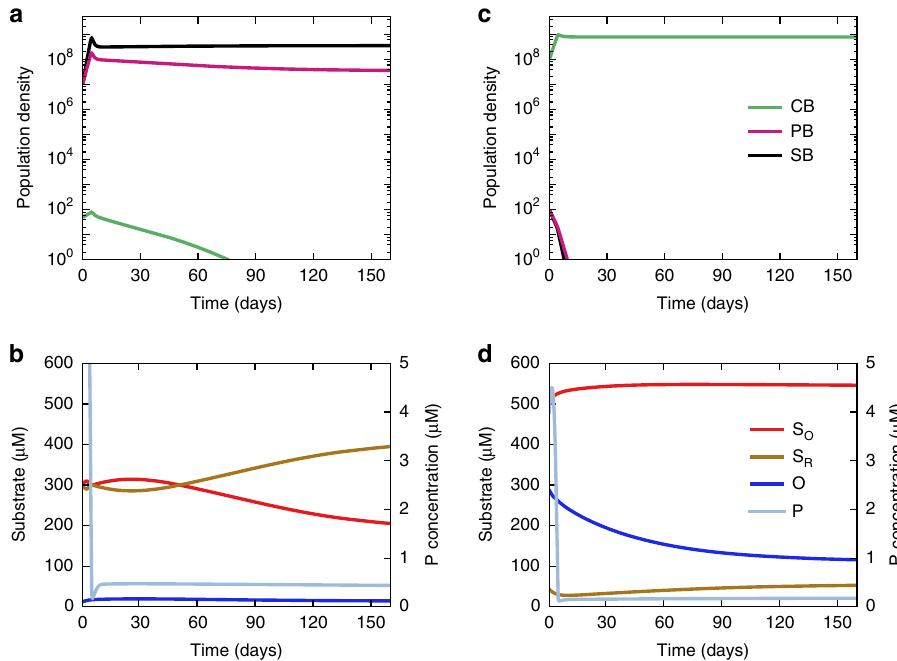
Fig. 2 Illustration of the two alternative stable states. a , b When the model starts with a low initial population density of cyanobacteria (CB), it develops towards an anoxic ecosystem with, a high abundances of phototrophic sulfur bacteria (PB) and sulfate-reducing bacteria (SB) and, b a high concentration of reduced sulfur ( S R ) but low oxygen concentration ( O ). c , d When the model starts with a high initial population density of cyanobacteria, it develops towards an oxic ecosystem with, c high abundances of cyanobacteria and, d high concentrations of oxygen and oxidized sulfur ( S O ). Parameter values are given in Supplementary Table 1, with P b = 9.5 μ M, α O = 8 × 10 − 4 h − 1 . Initial conditions: a , b N PB = N SB = 1 × 10 7 cells L − 1 , N CB = 5 × 10 1 cells L − 1 , S O = 300 μ